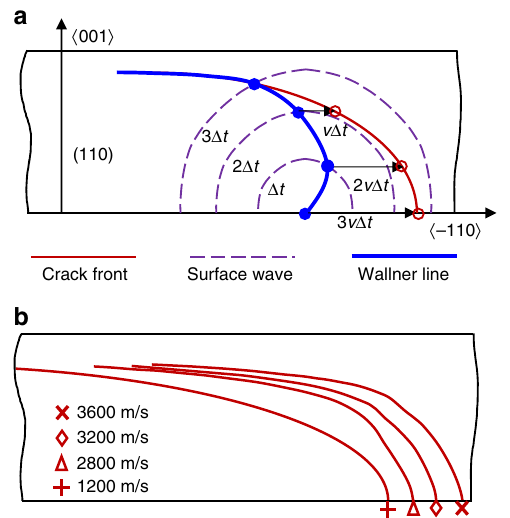
Fig. 3 Crack front identi fi cation, method and results. a Method for recovering the crack front shape from Wallner lines and surface waves. The blue solid line denotes the crack front, the dashed ones stand for the propagating surface waves, and the red one represents the Wallner line. b Crack front shapes for a slow crack propagating at 1200 m/s and a rapid one at 3600 m/s, along with cracks propagating at intermediate velocities.